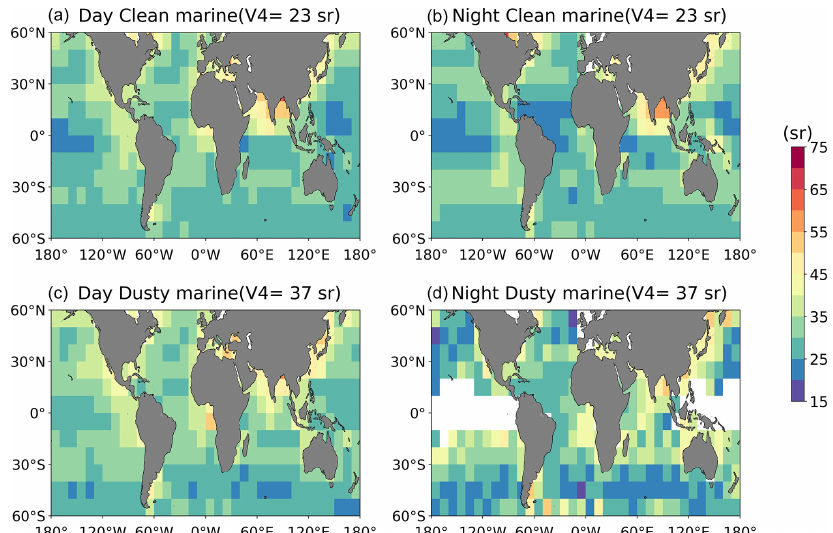
Figure 11. Median CALIPSO–SODA lidar ratio for clean marine (a, b) and dusty marine (c, d) classified from 5 and/or 20km spatially averaged data. Maps are constructed with 10 ◦ × 10 ◦ regular grids, daytime and nighttime (panels a, c and b, d , respectively). Values are reported for grids constructed with at least 20 samples.